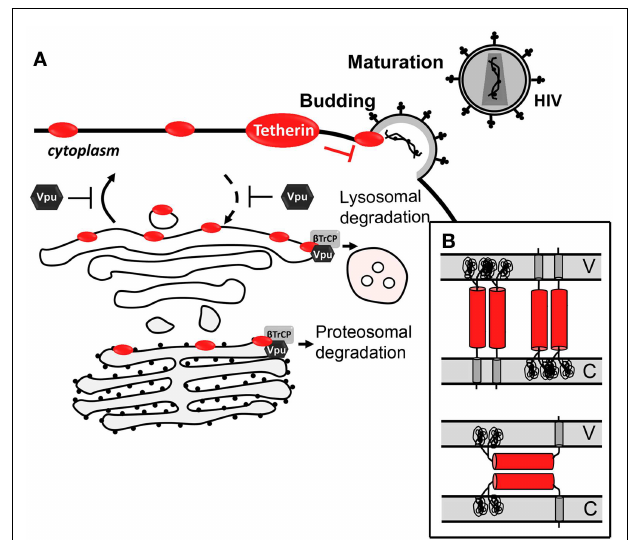
FIGURE 3 |Antiviral mechanism of tetherin . (A) Tetherin prevents Vpu-defective virus release by tethering newly formed virus to the cell-surface.Vpu counteracts tetherin by trapping it at theTGN or targeting it for proteasomal or lysosomal degradation. (B) Topological models for antiviral tetherin mechanisms. One end of tetherin is anchored at the cell plasma membrane and the other end is anchored at the surface of the virion (top); or both ends of one monomer of tetherin parallel homodimers are inserted in either the cell plasma membrane or the viral membrane (bottom).V stands for viral membrane and C stands for cellular